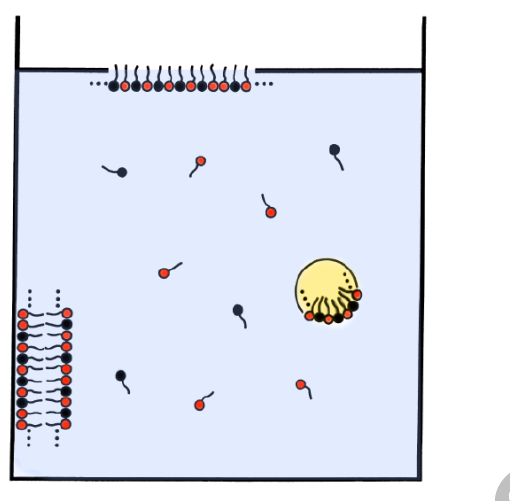
Fig. 11–Occurrence in a mixed surfactant system of two surfactant